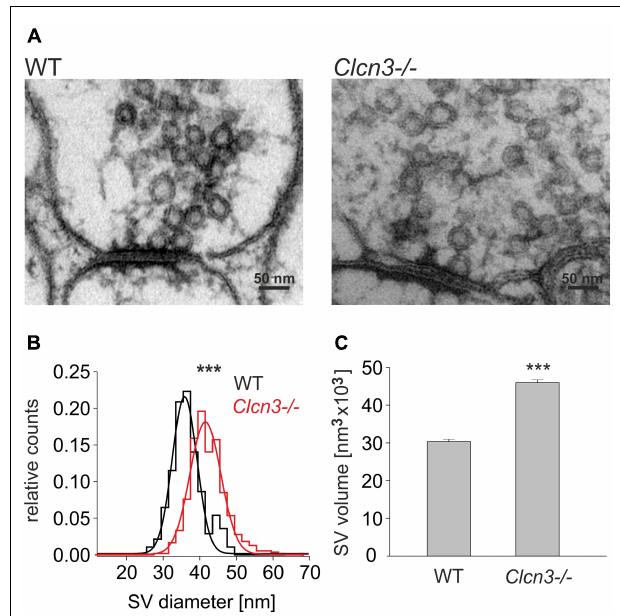
FIGURE 4 | ClC-3 regulates synaptic vesicle size. (A) Representative electron micrographs forWT and Clcn3 − / − synaptic terminals. (B) Distribution for synaptic vesicle diameters fromWT (black) and Clcn3 − / − (red) neurons. (C) Mean synaptic vesicle volumes fromWT or Clcn3 − / − neurons.Vesicle volumes were calculated from measured diameters assuming a spherical shape. Means ± SEM from 350WT and 550 Clcn3 − / − synaptic vesicles, three independent preparation ( ∗∗∗ p < 0.001, t